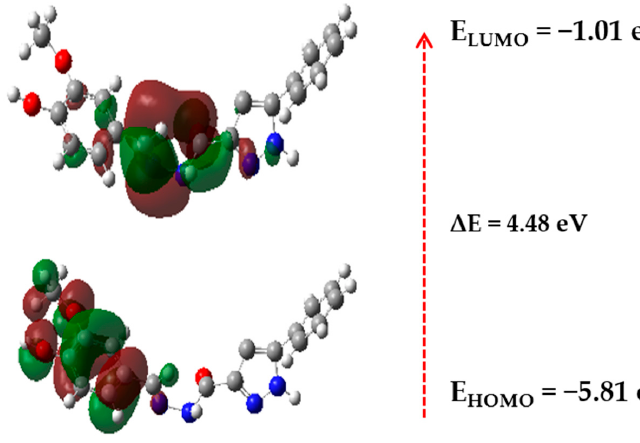
Figure 4. HOMO–LUMO energy diagram of L1 . Int. J. Mol. Sci. 2017 , 18 , 2215